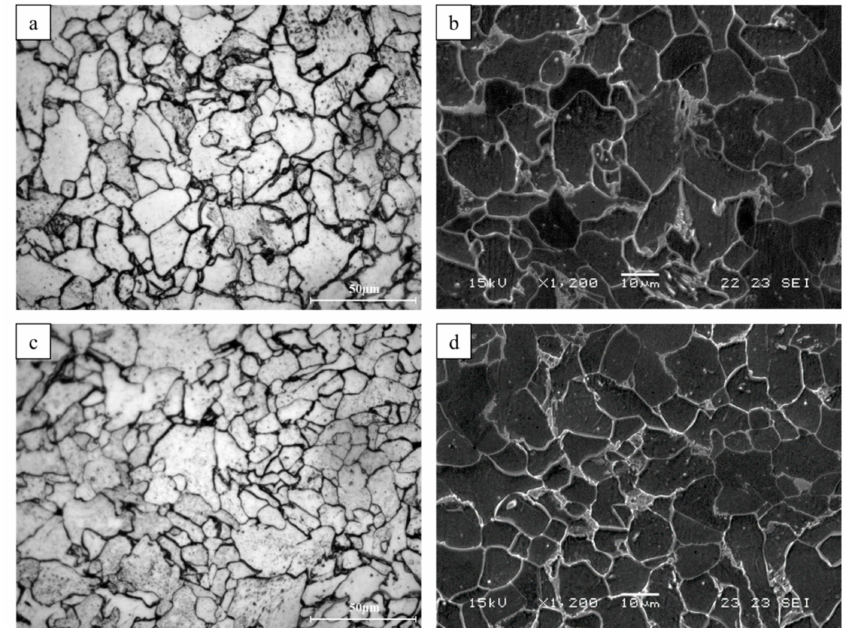
Figure 3. Typical microstructures of printed (WAAM) alloy ER70S-6 obtained by optical and SEM microscopy respectively ( a , b ) XY plane ( c , d ) XZ plane.